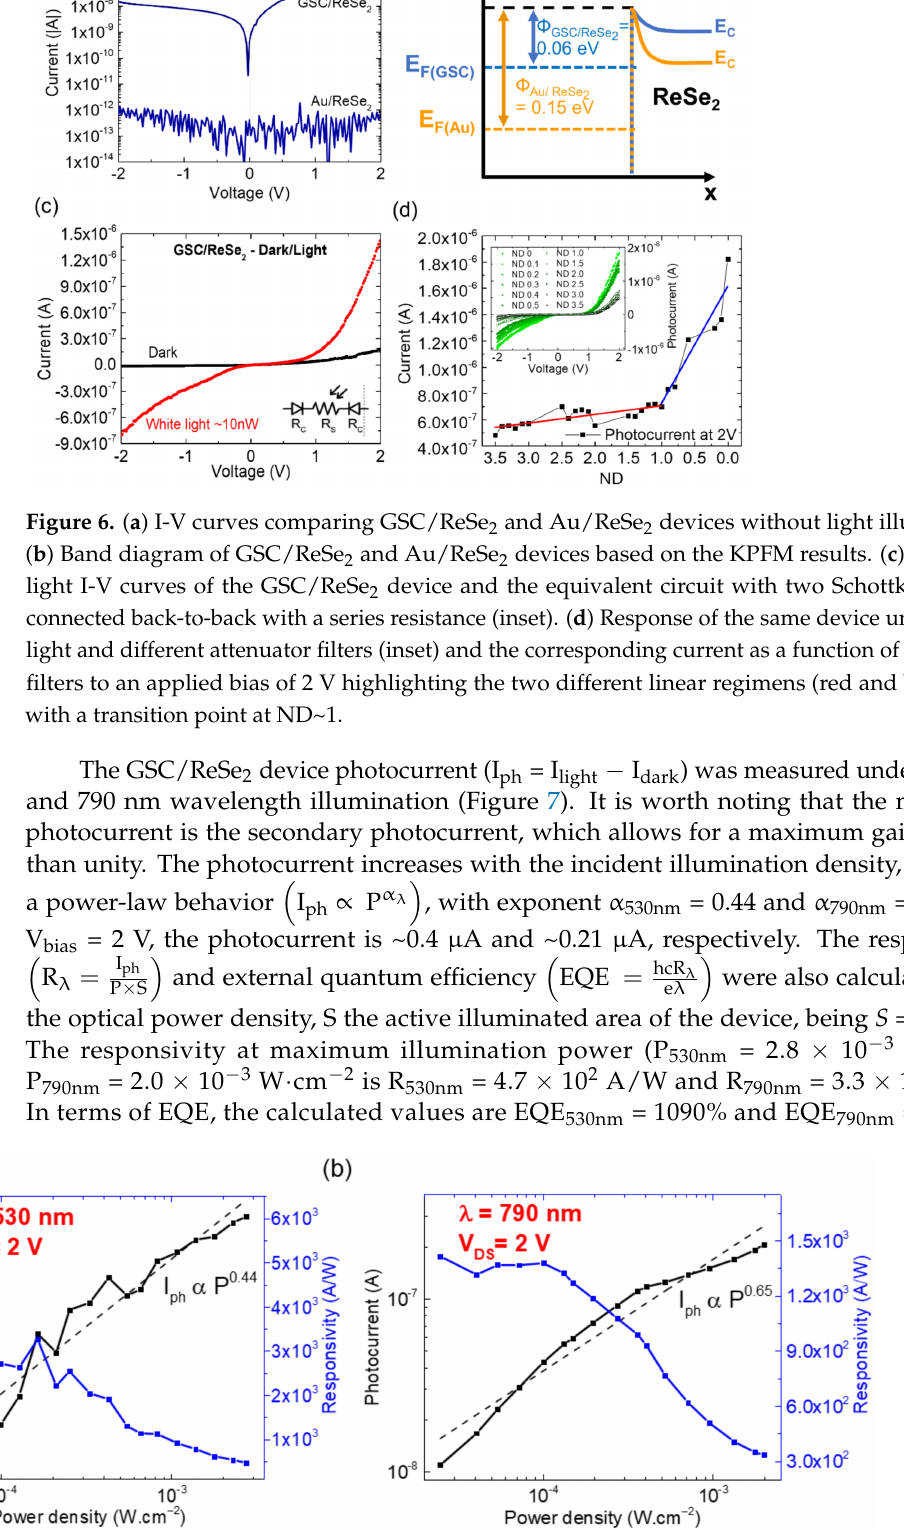
Figure 7. Photocurrent and responsivity as a function of irradiance under two different wavelengths exhibiting a P α trend ( a ) 530 nm with a fit line for α = 0.44 and ( b ) 790 nm with a fit line for α = 0.65 for GSC/ReSe 2